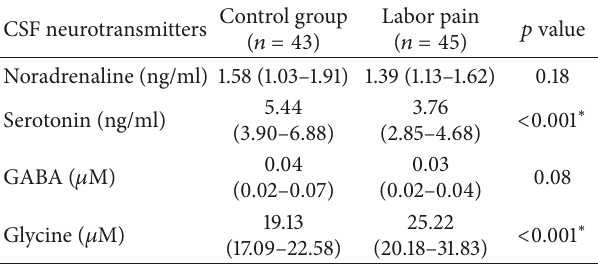
Table 2: Concentrations of CSF neurotransmitters in pregnant women in the control and labor pain groups. Control group CSF neurotransmitters ( 𝑛 = 43 )